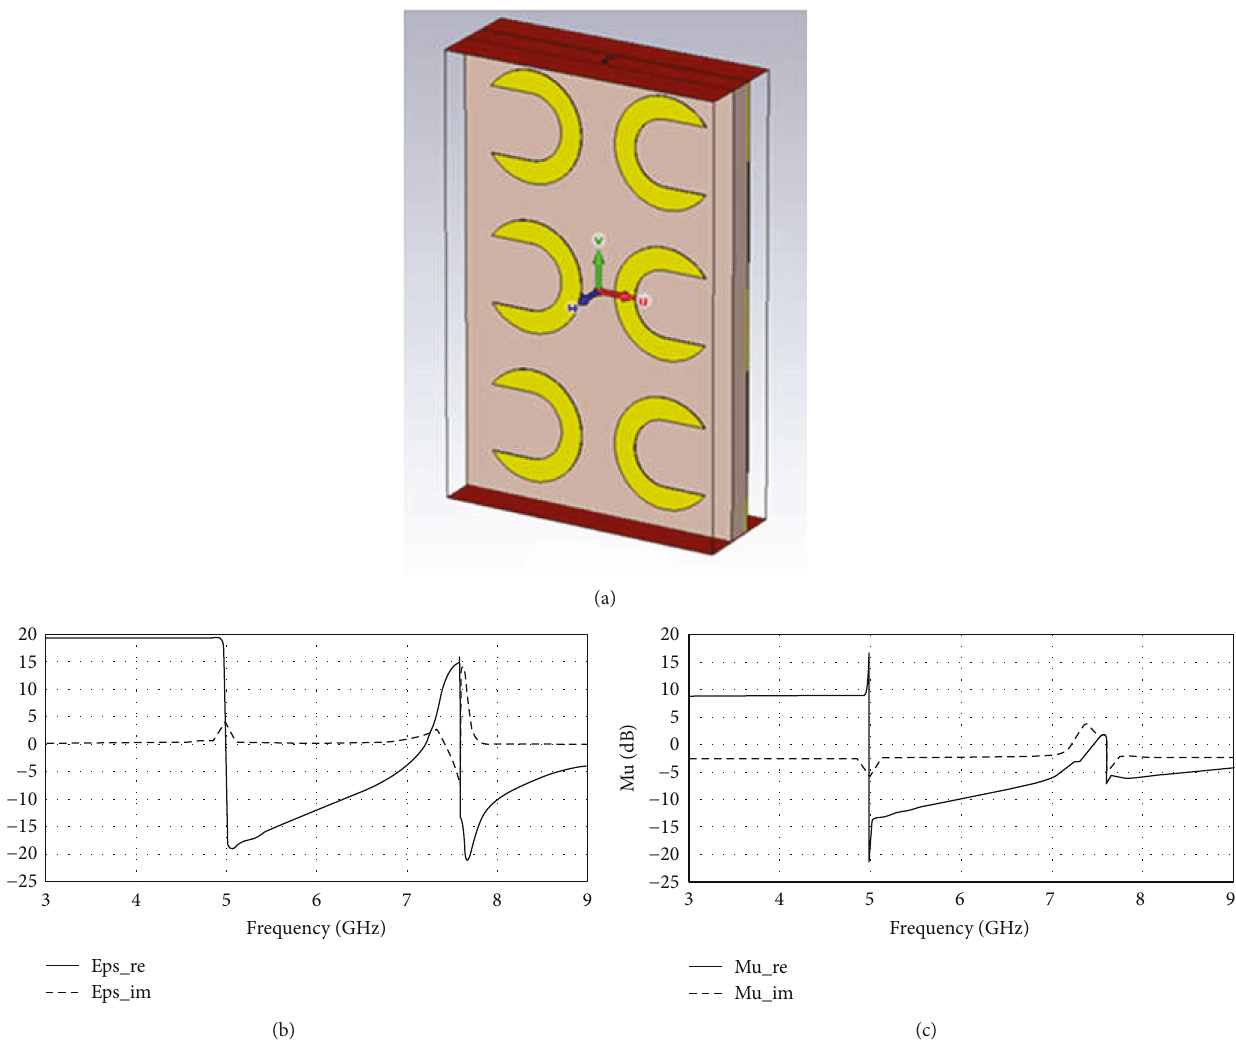
Figure 5: (a) 2 × 3 matrix of MTM-CSR, (b) e ff ective permittivity, (c) and e ff ective permeability.